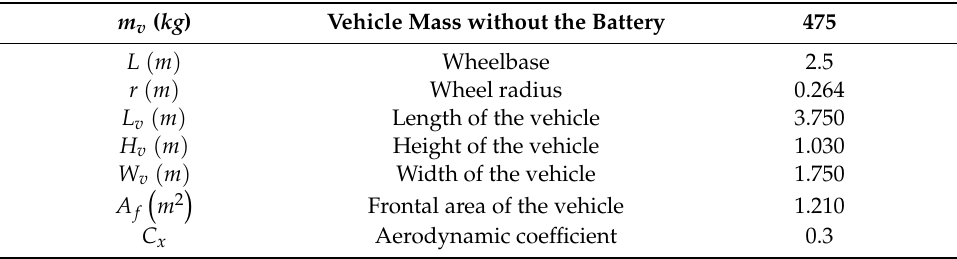
Figure 6. ICE vehicle. Table 1. Vehicle parameters.